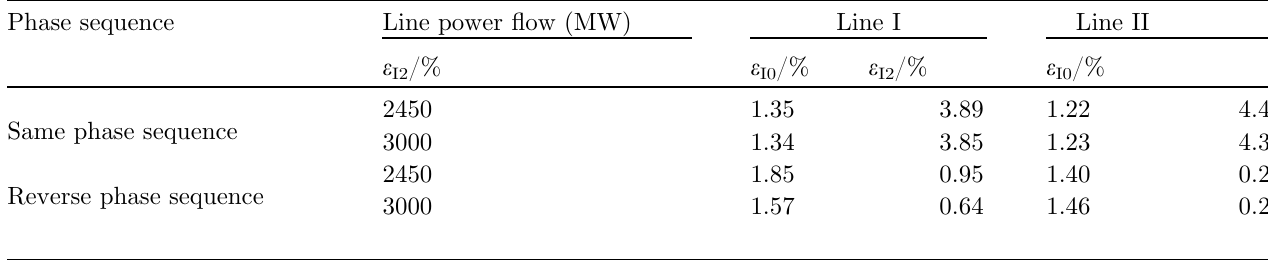
Table 9. In fl uence of line power fl ow on current